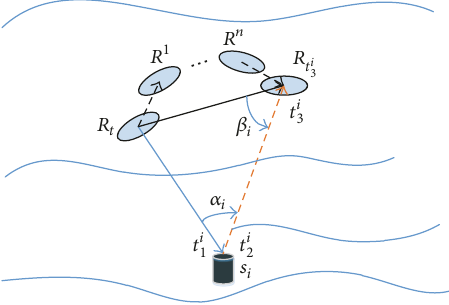
Figure 2: Model of TWTT between the AUV and transponder 𝑠 𝑖 .